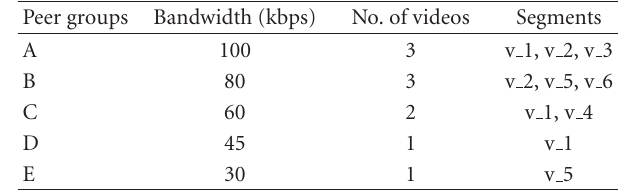
Table 5: Segment distribution in proposed P2P.